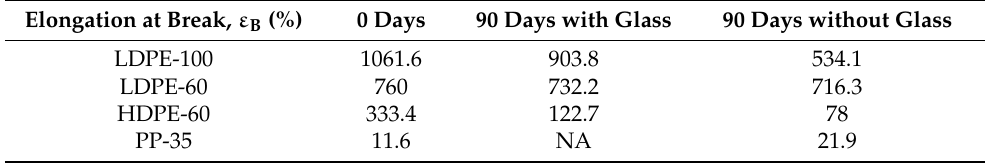
Table 8. Elongation at break averages for aging